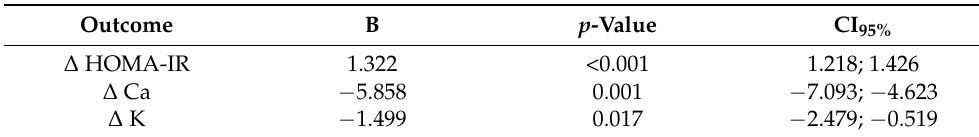
Table 3. Linear regression with stepwise analysis of the main predictors associated with the weight loss.